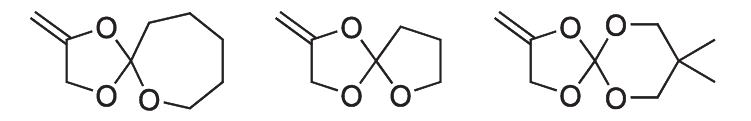
Figure 9. Some other examples for the radical ROP spiro